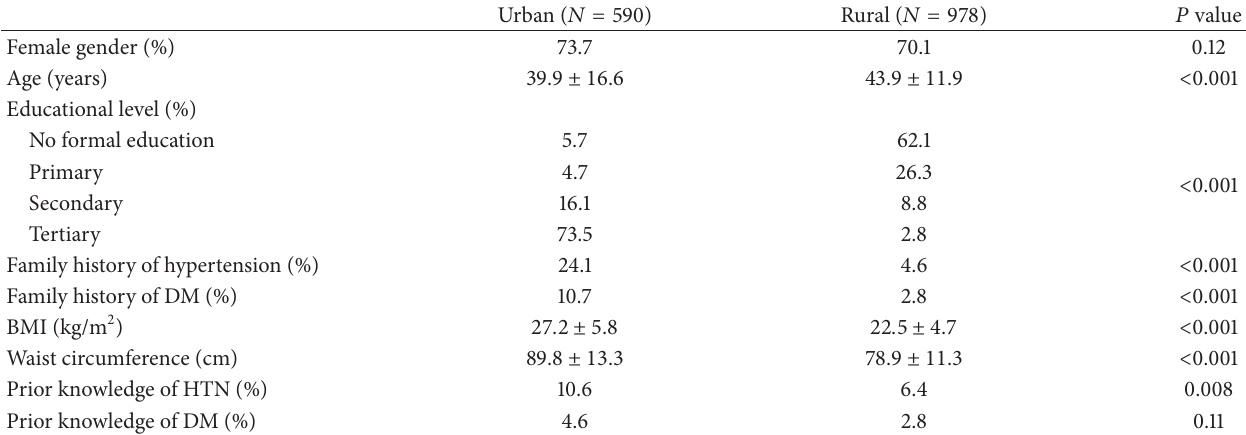
Table 1: Sociodemographic and clinical characteristics of study